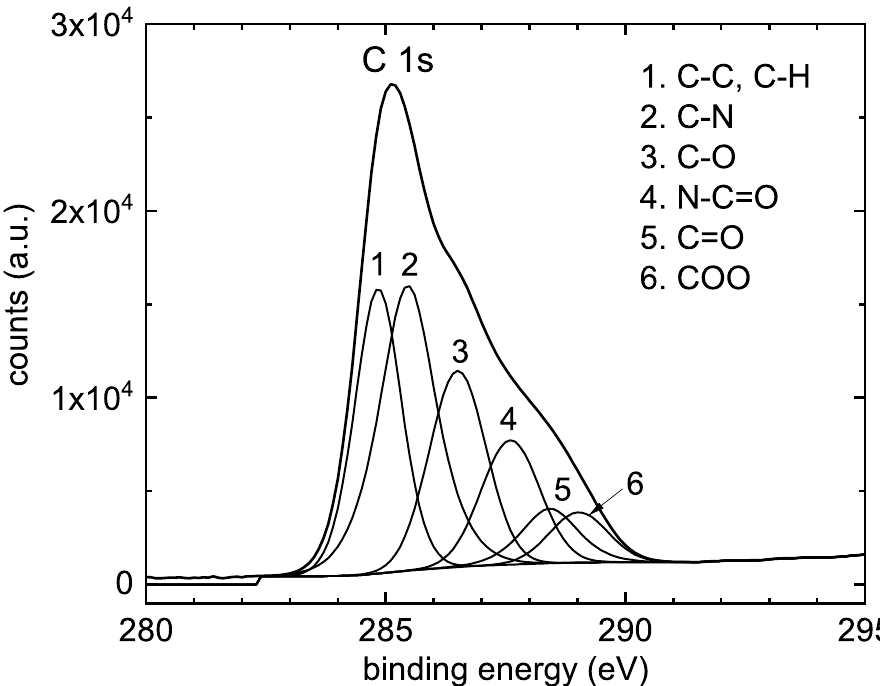
Figure 8. Curve fitting analysis of the high-resolution XPS C1s spectrum of POx film deposited at the substrate temperature of 90 ◦